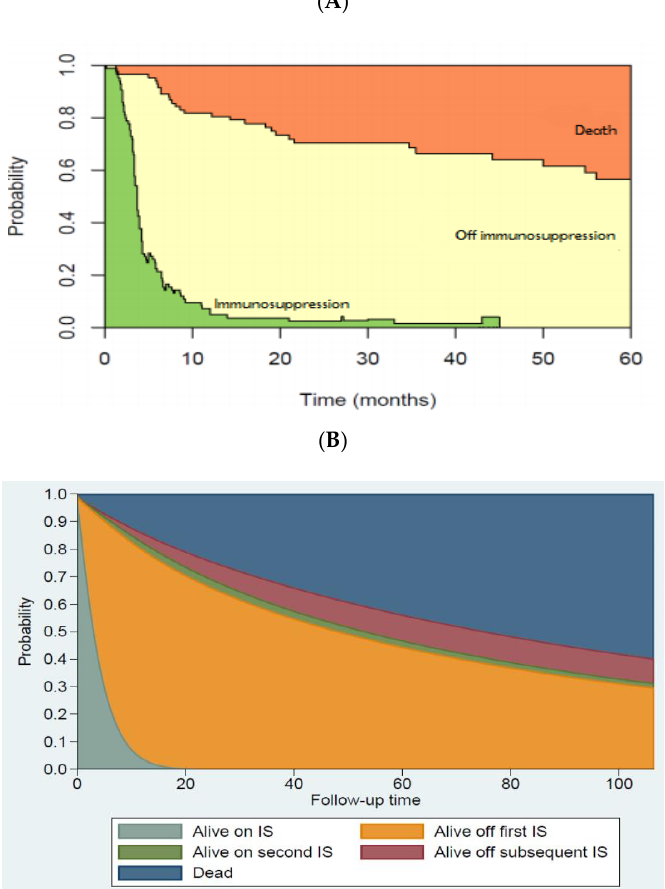
Figure 2. Immunosuppression Burden ( A ) Reversible multistate modeling the instantaneous prob- ability of being in 1 of 3 states: (1) alive, off immunosuppression (off immunosuppression, yellow zone), (2) alive, on immunosuppression (immunosuppression, green zone), or (3) dead (death, orange zone). All patients begin in state 1 on day +5 after transplant, after receiving cyclophosphamide 50 mg/kg on days +3 and +4. Patients may have reversible transition between states (1) and (2) but death was an absorbing state. ( B ) Nonreversible multistate modeling the instantaneous probability of being in 1 of five states: (1) alive, on immunosuppression (IS), (2) alive, off first IS, (3) alive, on second IS, (4) alive, off subsequent IS, or (5)